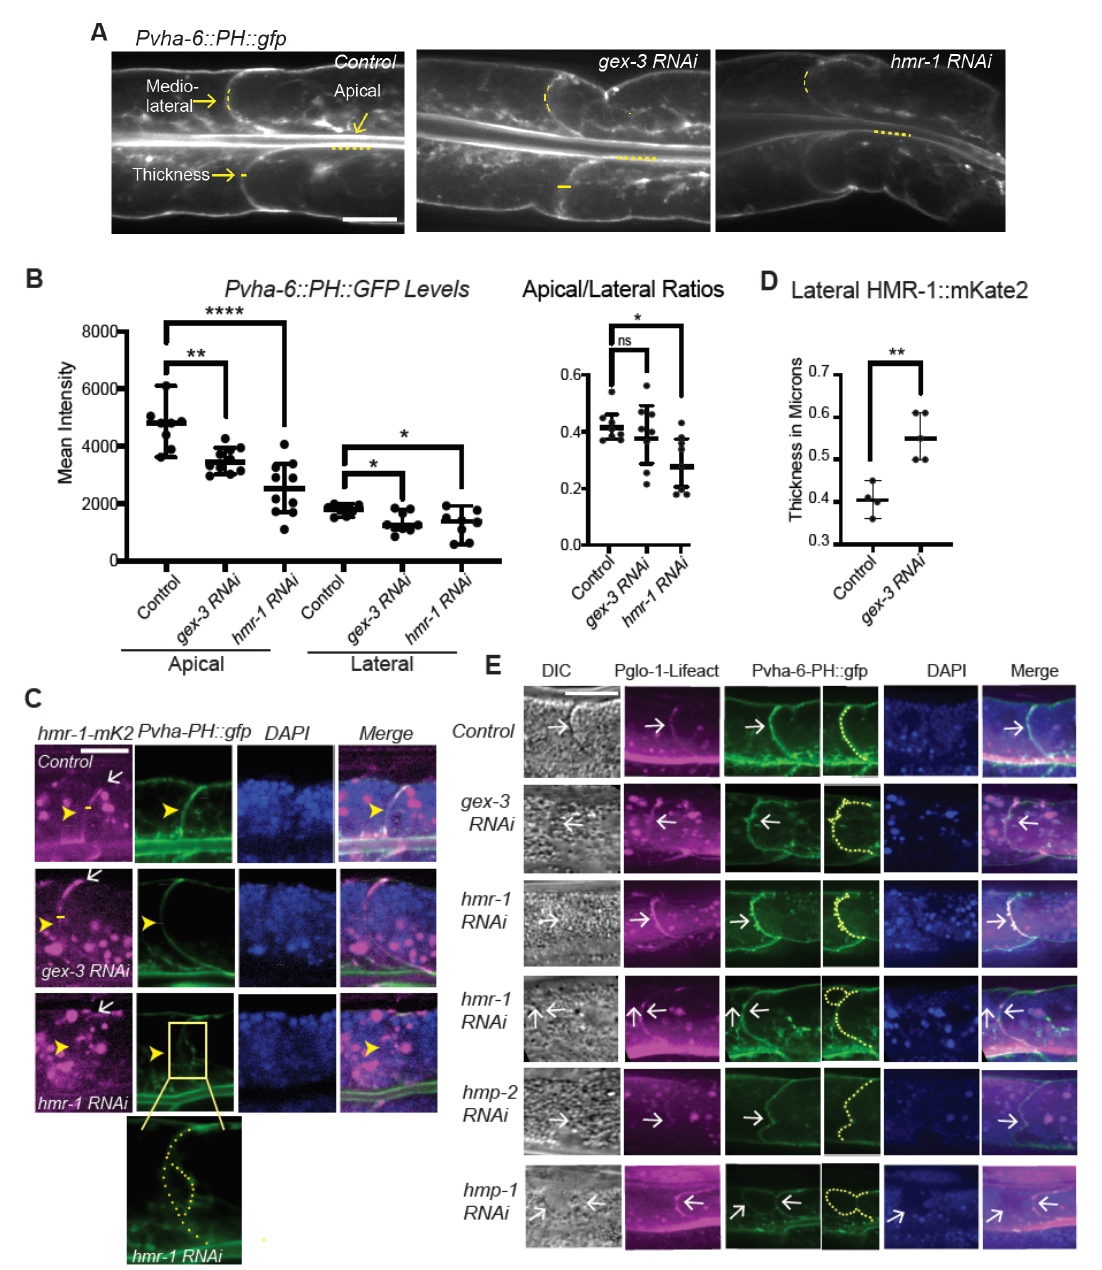
Figure 3. Cadherin lateral morphology depends on WAVE. ( A ) Pvha-6::PH::GFP labels the intestinal membrane, is a biosensor for PIP2, and can show the morphology of the cells. L4 controls and animals depleted of gex-3 or hmr-1 with three days RNAi feeding were compared for enrichment at apical and lateral regions. Scale bars are 5 μm long for all panels. ( B ). Mean intensity of the apical (luminal) and midlateral region of the intestinal ring 3 membrane. Each data point represents one or two measurements per animal: 5 Control, 5 gex-3 RNAi and 5 hmr-1 RNAi animals. Line scans of 80 pixels (7 μm) and 35 pixels (3 μm) were used to measure the lumen and midlateral membrane signal, respectively, indicated by the dotted yellow lines in ( A ). ( C ) The lateral membrane of Int3 was compared by monitoring Cadherin ( hmr-1::mKate2 ) and PIP2 (Pvha-6::PH::gfp ) on one side of the intestine, with all images in ( C ) and ( D ) oriented so that apical is down and basal is up. White arrows point to midlateral regions. ( D ) The thickness of the midlateral membrane region enriched in hmr-1::mKate2 was measured, as indicated by the yellow bars in panel A and C. Each data point represents one animal: 4 Controls, 5 gex-3 RNAi animals. ( E ) The lateral membrane of Int3 was further compared by monitoring a strain with both intestinal F-actin ( Pglo-1::Lifeact::TAG-RFP ) and intestinal PIP2 ( Pvha-6::PH::gfp). White arrows point to the lateral membrane and regions of altered F-actin or PIP2, including membrane distortions. * = p < 0.05, ** = p < 0.005, **** = p < 0.0005, ns = not